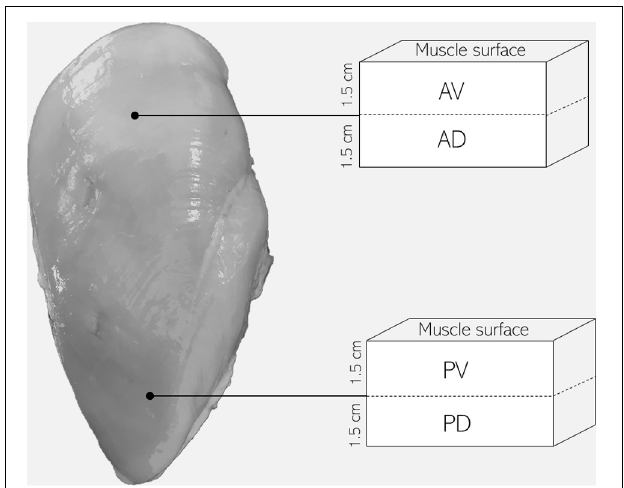
FIGURE 1 | Schematic diagram of pectoralis major muscle sampling location for the evaluation of muscle histology and sarcomere length (AV, anteroventral; AD, anterodorsal; PV, posteroventral; PD,